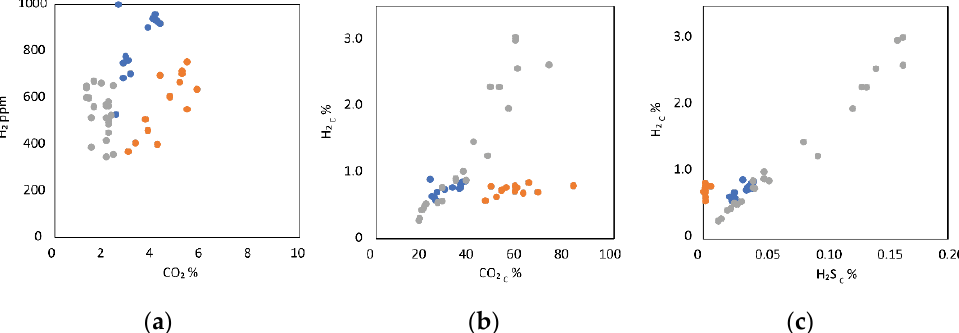
Figure 9. Diagram illustrating gas concentrations for the DJI-4 fumarole. ( a ) Non-corrected gas with H 2 in ppm versus CO 2 in %. ( b ) H 2 (%) versus CO 2 (%) after air correction. ( c ) H 2 (%) versus H 2 S (%) after air correction. Measurements were obtained on 21 November 2019 (orange dots), 12 August 2020 (blue dots), and 13 August 2020 (gray dots). Table 4. Average air-corrected gas compositions from the site 4 field measurements. F: fumaroles; n: number of measurements.